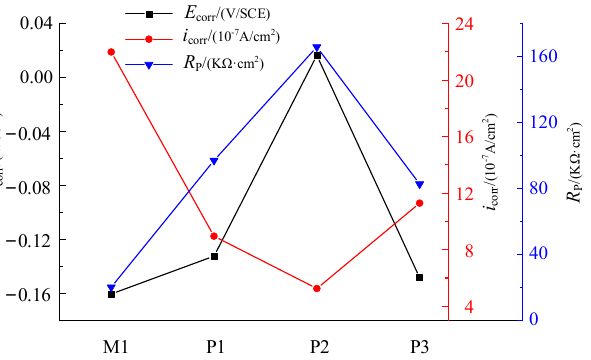
Figure 9. Variation of corrosion parameters of milling and electrochemical polishing samples.